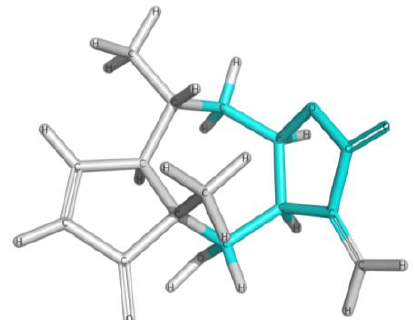
Figure 6. Maximum common structure (cyan atoms of compound 01) of dataset calculated by all HQSAR